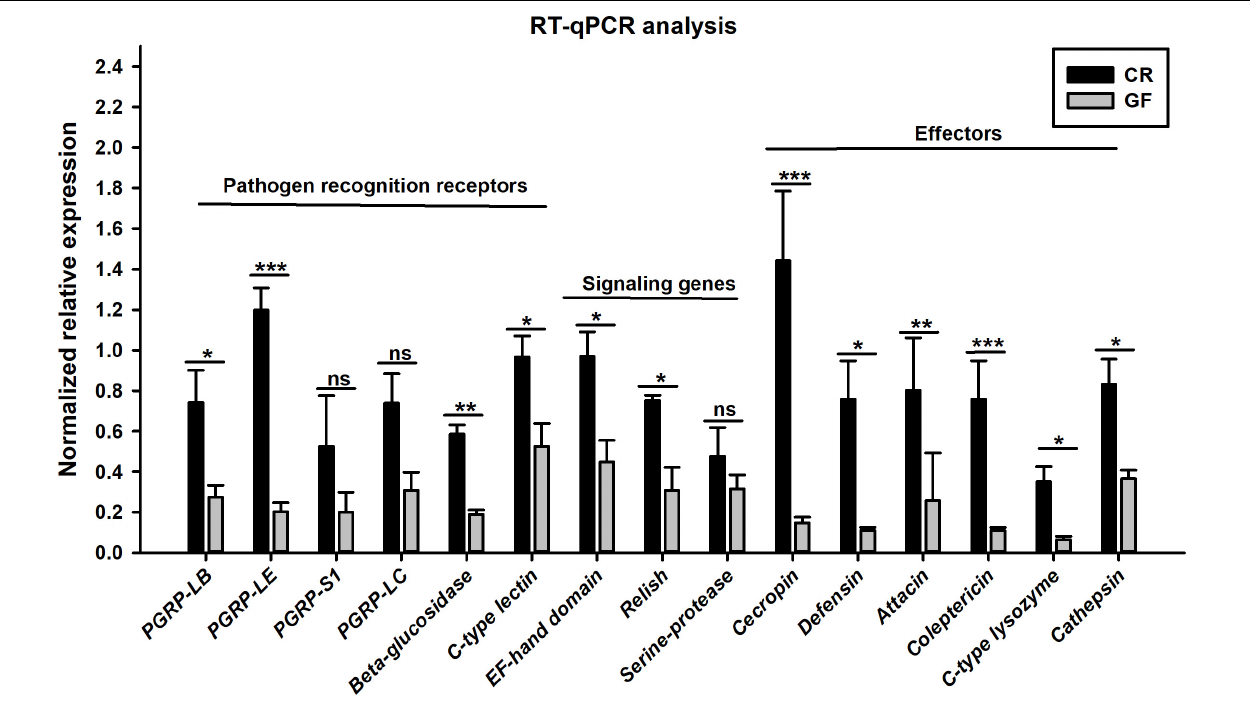
FIGURE 6 | RT-qPCR verification on the transcript abundance of immunity-related genes in the guts of CR and GF RPW larvae. Asterisks indicate statistical difference ( P < 0.05) between the CR and GF individuals ( t -test: ns, P > 0.05, ∗ P < 0.05, ∗∗ P < 0.01, ∗∗∗ P < 0.001). The fold changes of genes were calculated by normalizing to that of the reference gene, Rf β -actin , with the 2 − (cid:49)(cid:49) Ct method. Error bars represent the standard deviation of three independent biological replicates.